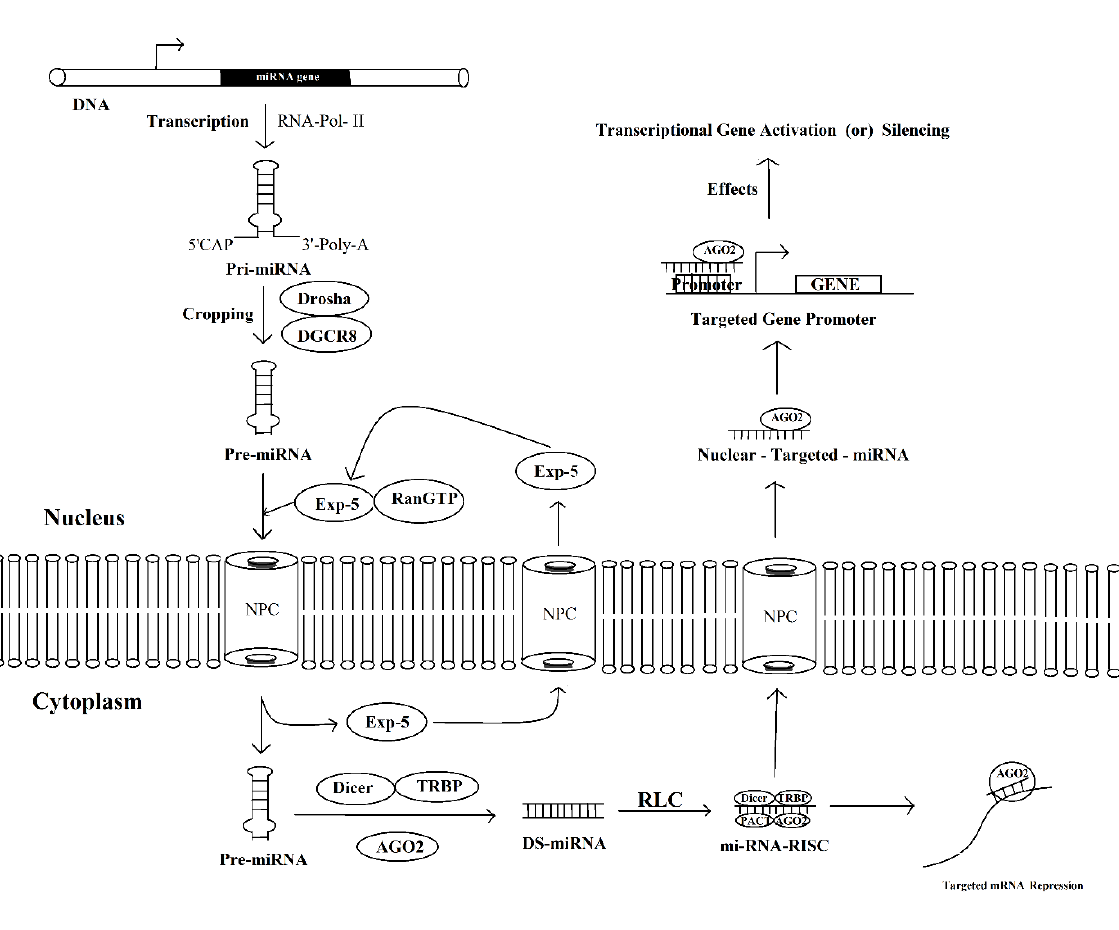
Figure 1: MicroRNA biogenesis and nuclear transport and gene regulation. Schematic diagram shows the series of reactions involved in the formation of mature miRNA and the role of miRNA in gene regulation [6-8, 10, 13, 18, 23-24, 28]. Only part of this series was considered for